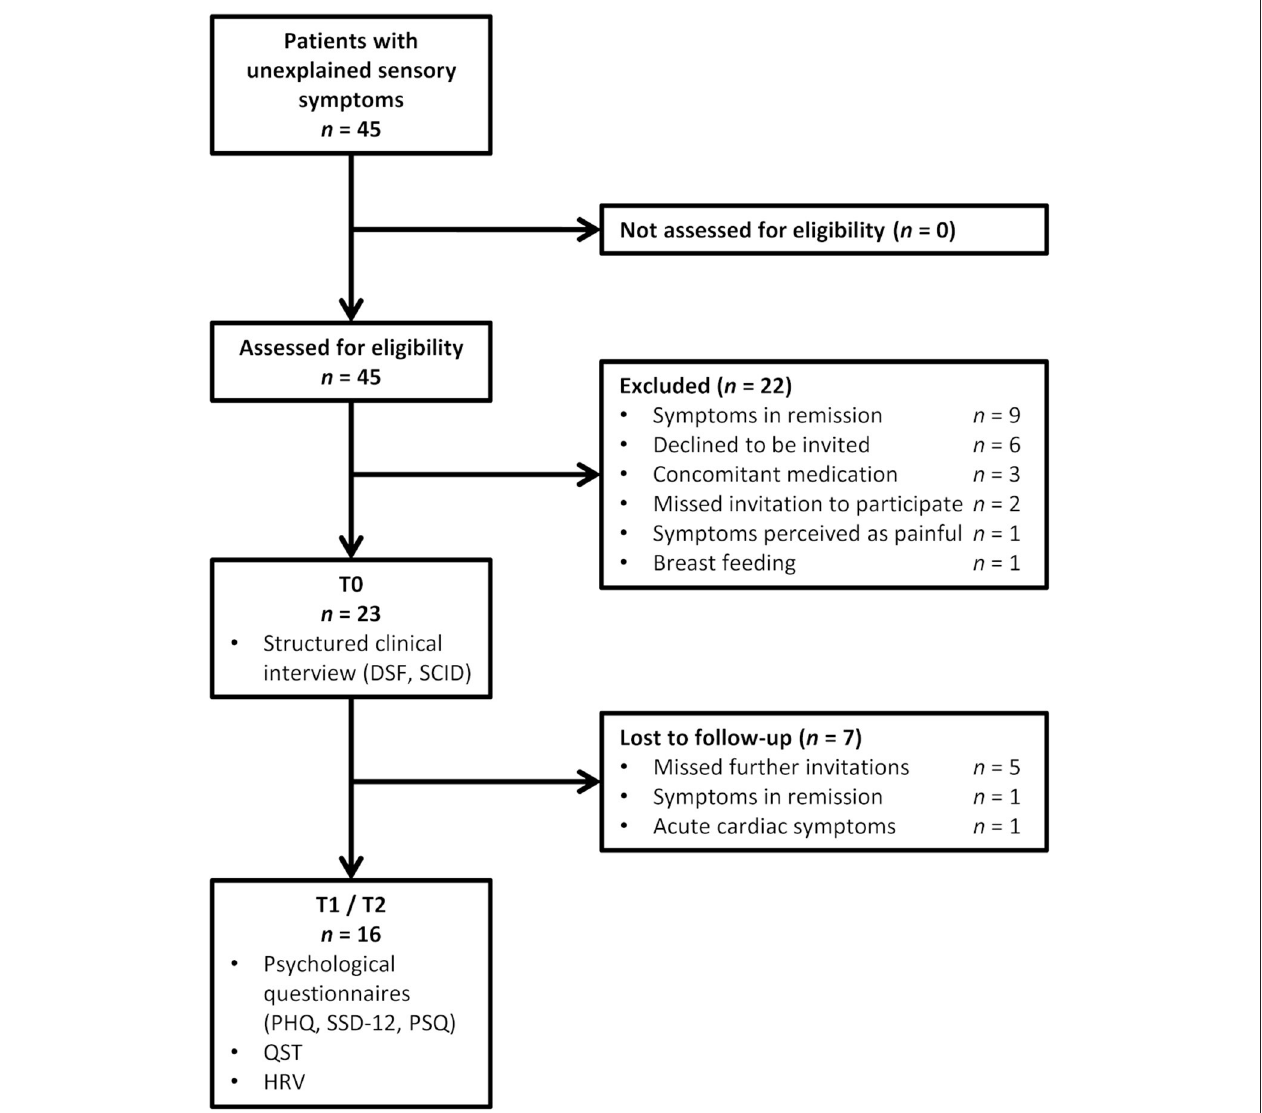
FIGURE 2 | Flowchart for patient inclusion (SCID, Structured clinical interview for mental disorders; DSF, modified German pain questionnaire; PHQ, Patient Health Questionnaire; SSD-12, somatic symptom disorder questionnaire; PSQ, perceived stress questionnaire; QST, quantitative sensory testing; HRV, heart rate variability